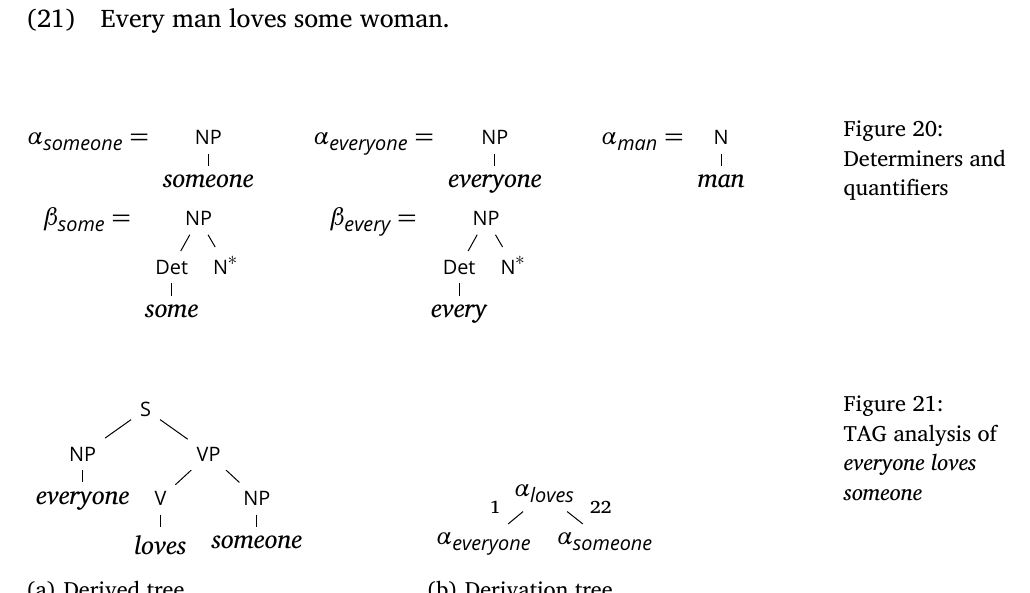
TAG analysis of